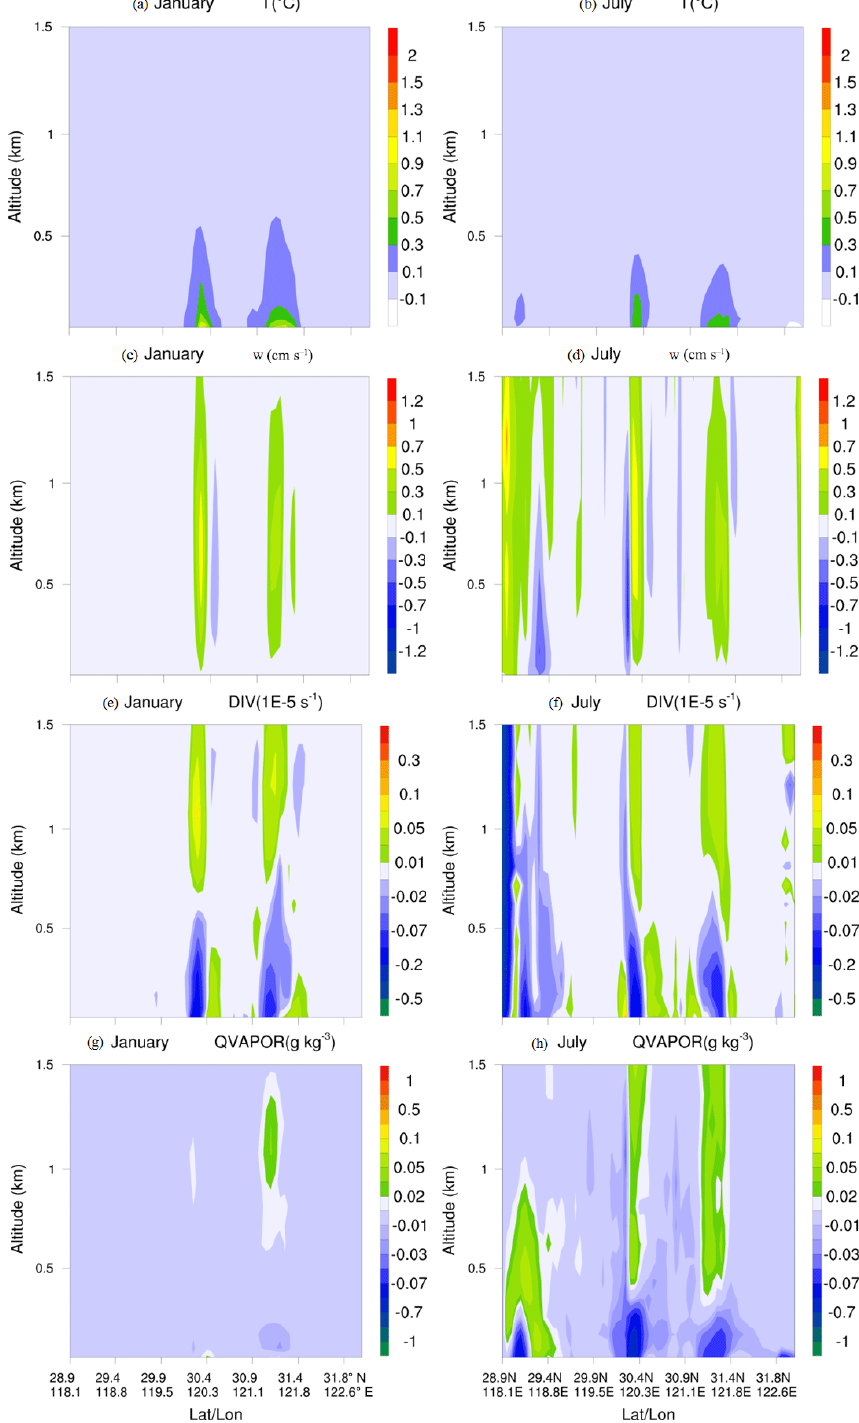
Figure 9. The vertical distribution of monthly averaged differences for air temperature ( T ), vertical wind velocity ( w ), divergence (DIV), and water vapor mixing ratio (QVAPOR) between ADDAH and NONAH (ADDAH-NONAH) from surface to 1.5km altitude along line AB (shown in Fig. 2b). Panels (a) , (c) , (e) and (g) show changes in January. Panels (b) , (d) , (f) and (h) illustrate variations in July. Differences that are non-significant under the 95% confidence level (Student’s t test) are masked